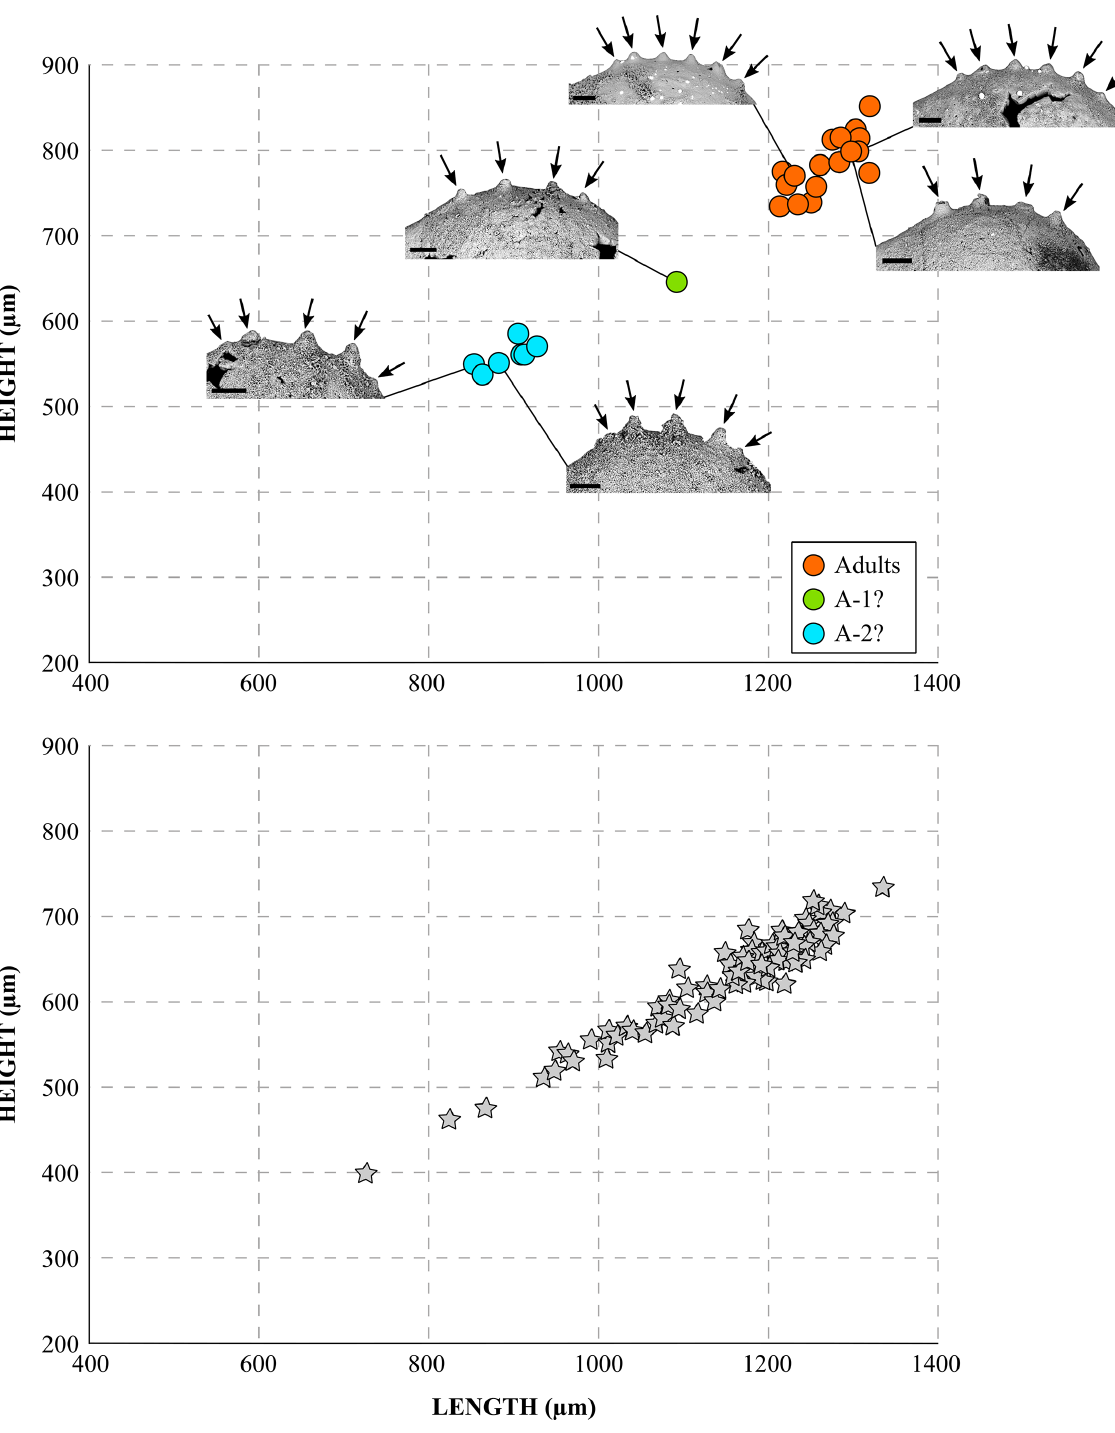
Fig. 10. Height/length scatter plots of Ceratobairdia wordensis (Hamilton, 1942) from the Middle Permian (Roadian, Capitanian) of the Guadalupe Mountains (West Texas, USA). Top: left valves (arrows pointing to dorsal spines), bottom: right